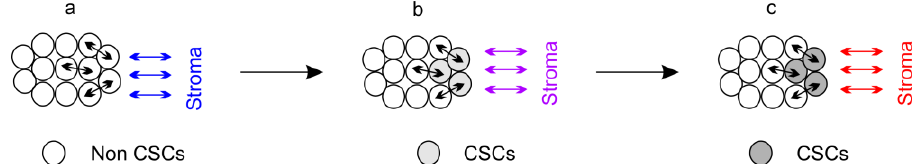
Figure 2. A dynamic model of cancer stem cells (CSCs). Intratumoral communications (black arrows with double directions) and tumor stromal communications (colored arrows with double directions) in ( a ) lead to the generation of CSCs ( b ). These communications will also drive CSC evolution ( c